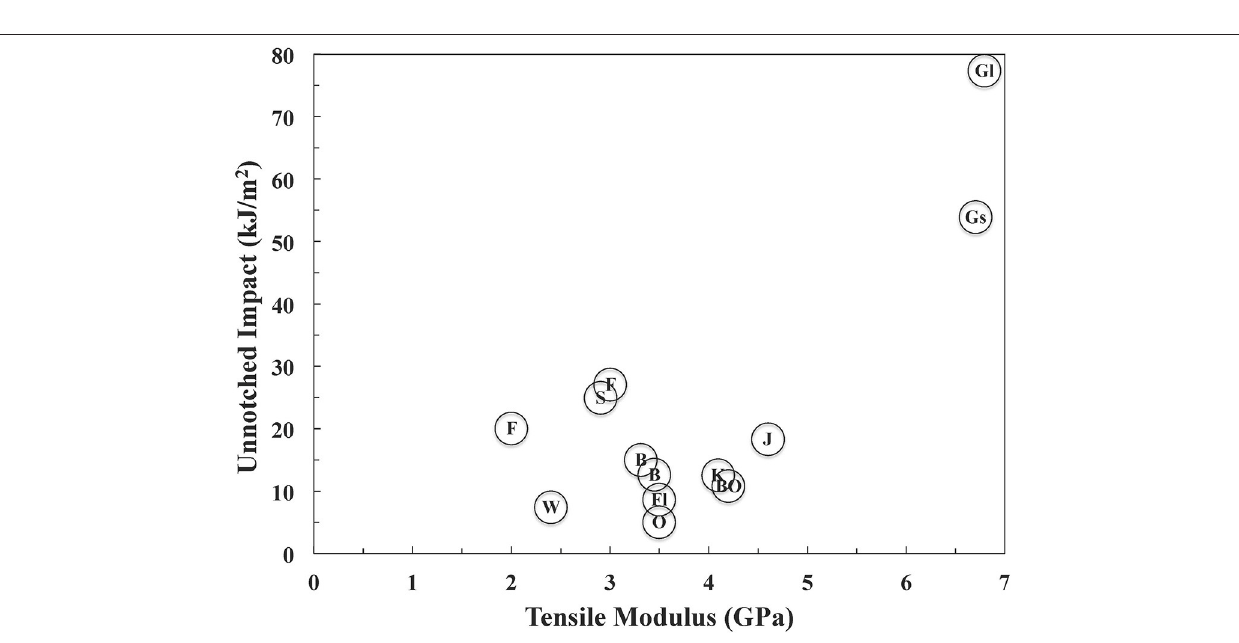
Frontiers in Materials |